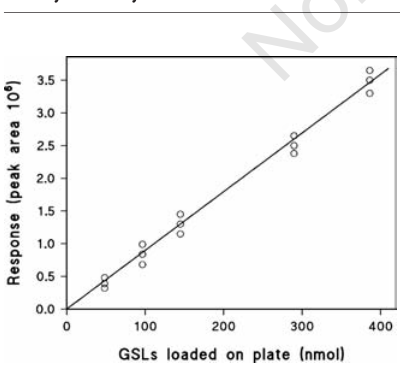
Figure 1. Chromatogram of glucosinolates of Camelina sativa Calena. GSL1, 9-methyl- sulfinyl-nonyl GSL; GSL2, 10-methyl- sulfinyl-decyl GSL; GSL3, 11-methyl- sulfinyl-undecyl GSL; UK, unknown.